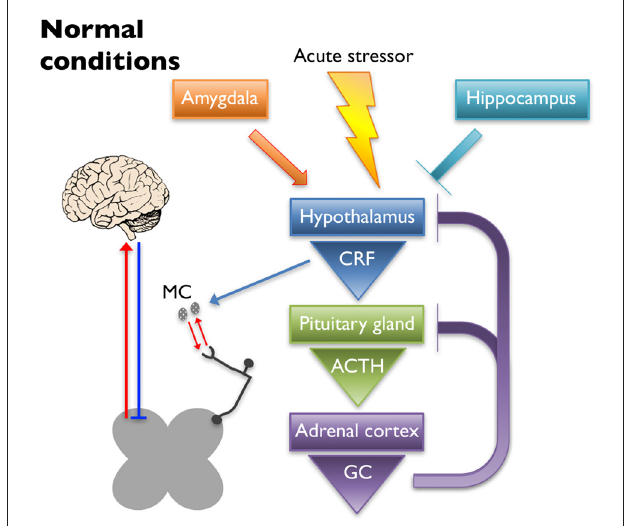
FIGURE 1 | Under normal conditions, an acute stressor will signal the paraventricular nucleus (PVN) of the hypothalamus to release corticotropin-releasing factor (CRF) into the hypophyseal portal veins, which causes the anterior pituitary gland to release adrenocorticotrophic hormone (ACTH). Circulating ACTH signals the adrenal cortex to release glucocorticoids (GC) that have downstream metabolic effects. A negative feedback loop is established to turn off activation of the hypothalamic-pituitary-adrenal (HPA) axis by suppressing the production of CRF and ACTH upon cessation of the initial stressor. The hippocampus and the amygdala play inhibitory and excitatory roles in regulation of the HPA axis, respectively. CRF released upon HPA axis activation also has peripheral effects. Mast cells (MC) can become activated by CRF, causing the release of cytokines and growth factors that have reciprocal interactions with peripheral nociceptors. Nociceptor activation signals through the dorsal horn of the spinal cord, leading to activation of supraspinal somatosensory brain regions. The descending pain pathway also plays a role in the regulation of painful